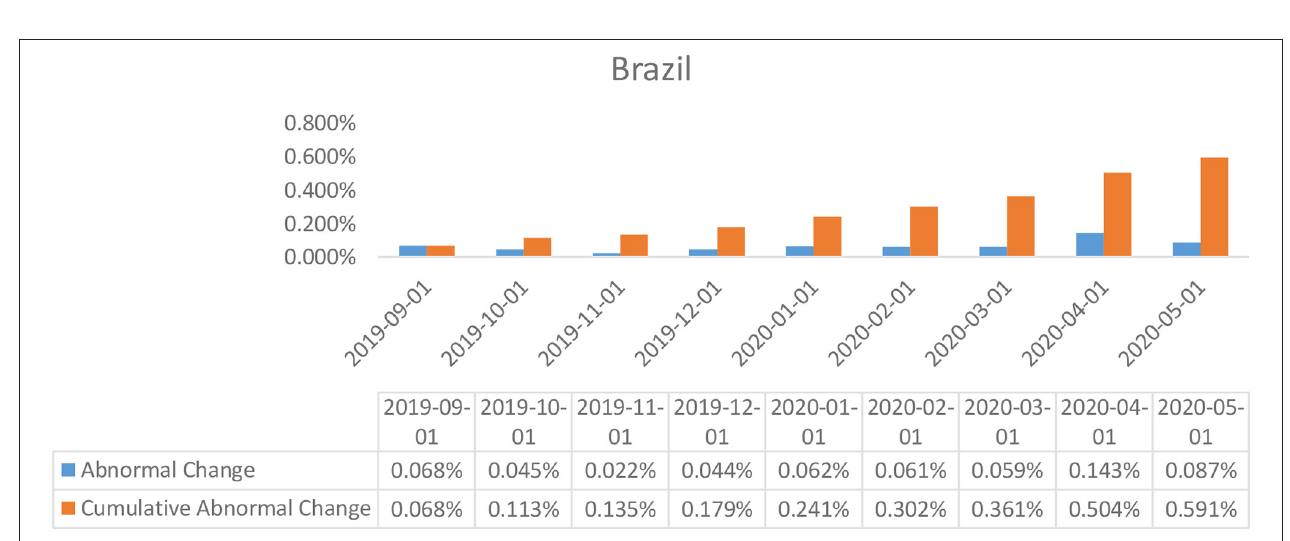
FIGURE 4 | Abnormal changes in policy interest rates over the event window: India.